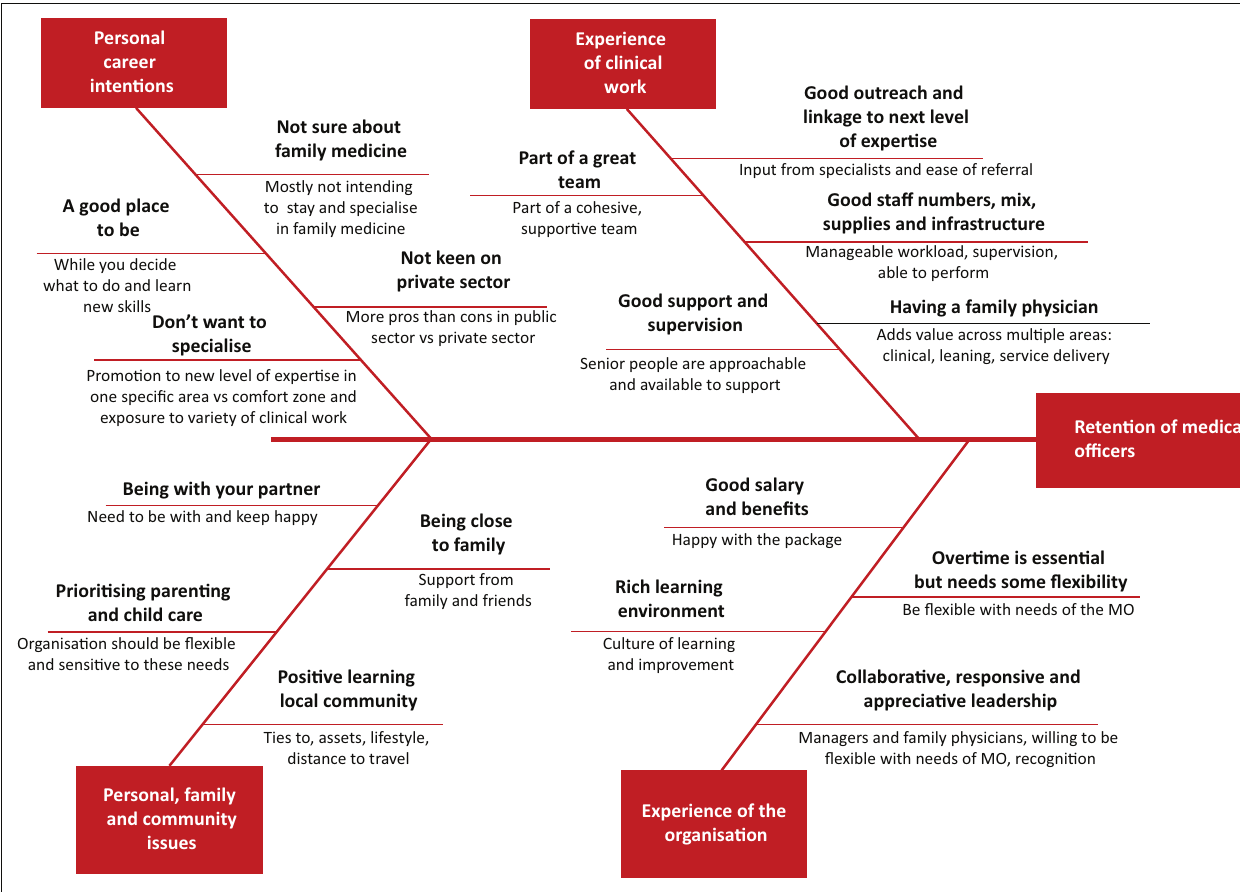
FIGURE 3: Summary of key